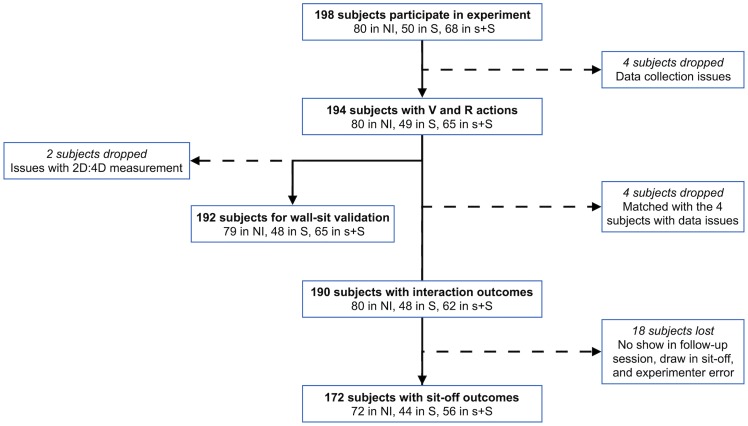
Sample breakdown.